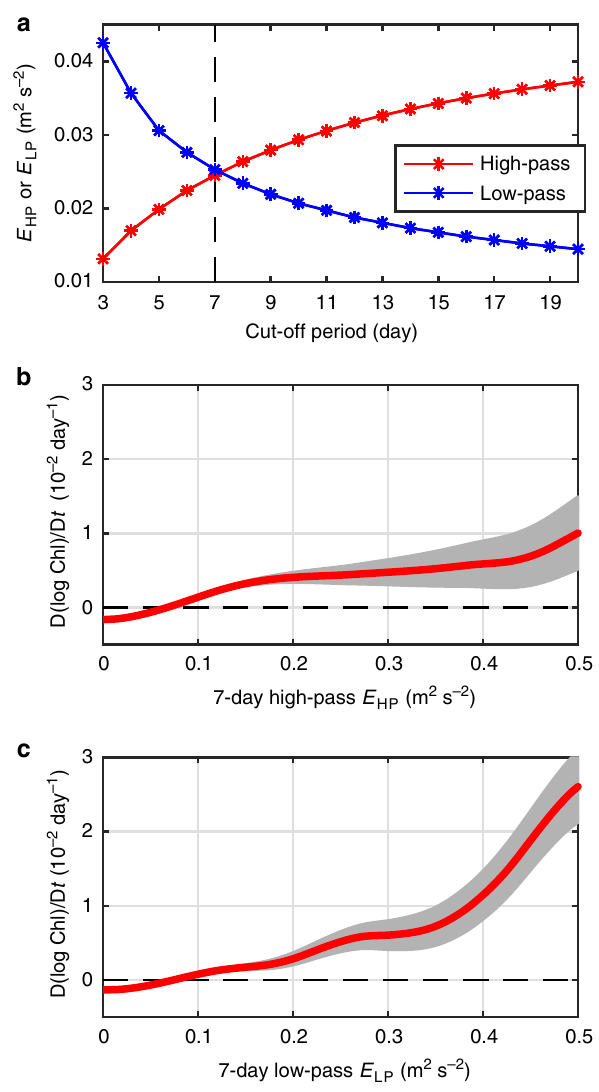
Fig. 6 Chlorophyll variation rate changing with ageostrophic kinetic energy. a Globally averaged high-pass and low-pass fi ltered ageostrophic kinetic energy changing with the cut-off period of the fi lter. The dashed line at 7-day denotes the cut-off period where the high-pass/low-pass fi ltered ageostrophic kinetic energy levels are equal. b Globally averaged curves of Lagrangian chlorophyll variation rate D(log Chl)/D t as a function of 7-day cut-off high-pass ageostrophic kinetic energy E HP . c Same as b , but for 7-day cut-off low-pass ageostrophic kinetic energy E LP . The chlorophyll variation rate is composited against the high-pass and low-pass ageostrophic kinetic energy E HP and E LP , using a moving average window with a width 0.05 m 2 s − 2 . The red curve in each sub fi gure represents the average curve and the light-gray shading represents the error bar computed by the standard error of the average. Source data are provided